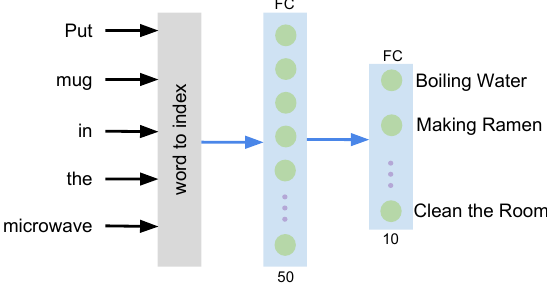
Figure 2: An MLP neural network is used to implement the inten- tion detection. The Tell-Me-Dave corpus is used to train the neural